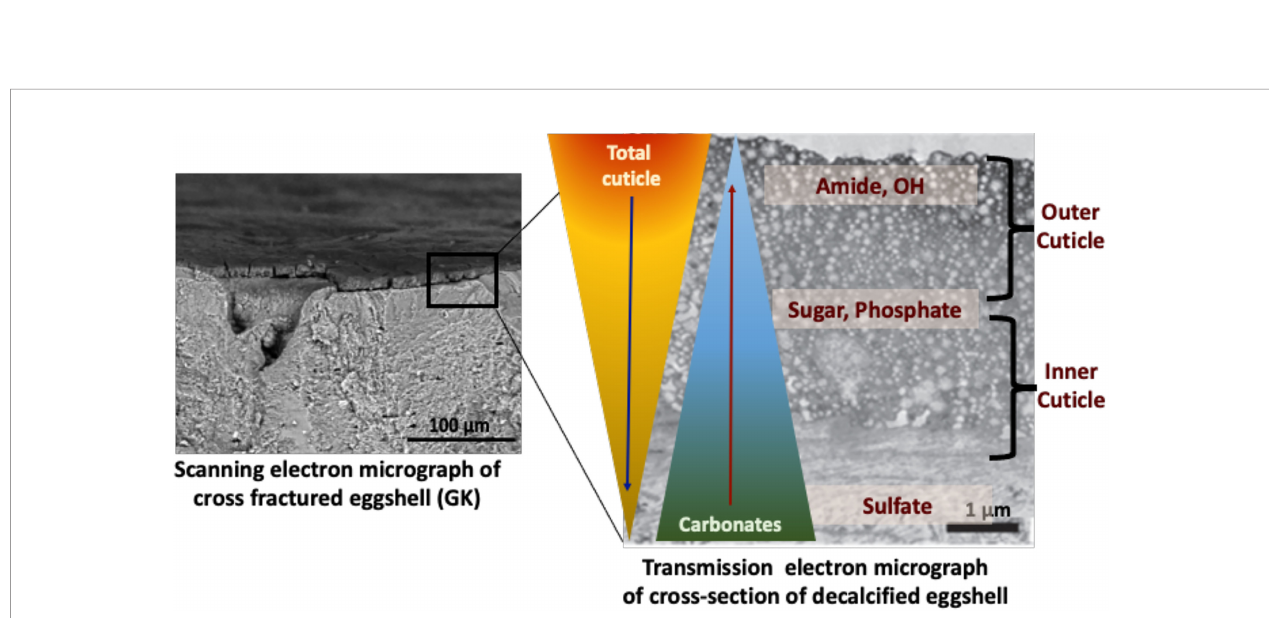
FIGURE 6 | Proposed compositional gradient in the eggshell cuticle with predicted distribution of proteins, phosphoproteins, glycoproteins, and sulphated proteoglycans. Reprinted from Foods, Vol. 10, Issue 11, Kulshreshtha et al., Impact of different layer housing systems on eggshell cuticle quality and Salmonella adherence in table eggs, 2559, 2021, with permission from